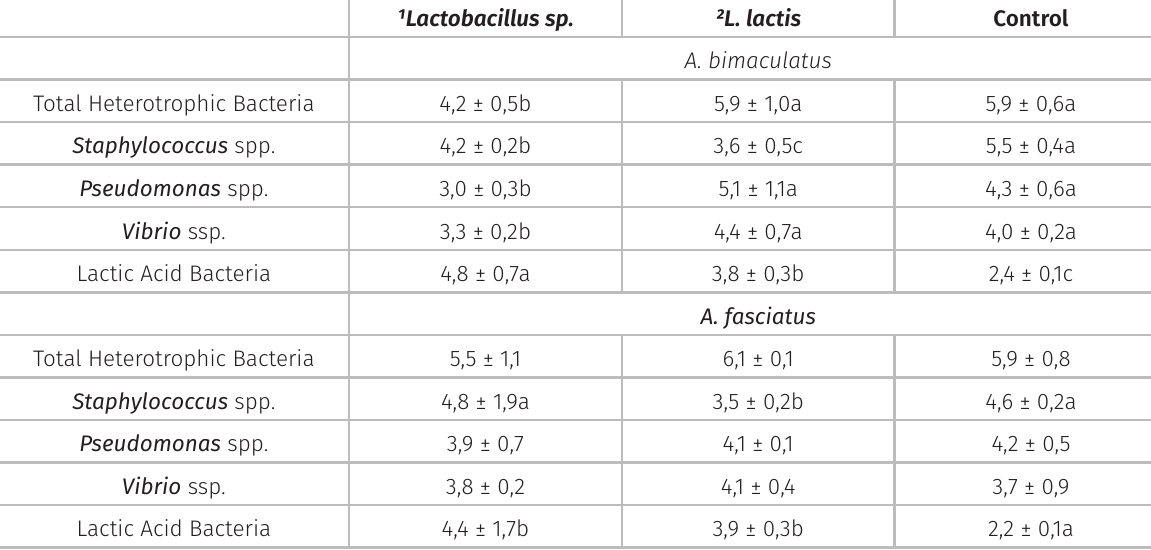
Table I. Bacterial count of the intestinal tract (Log UFC/g) of Astyanax bimaculatus and A. fasciatus fed diet supplemented with autochthone and allochthone